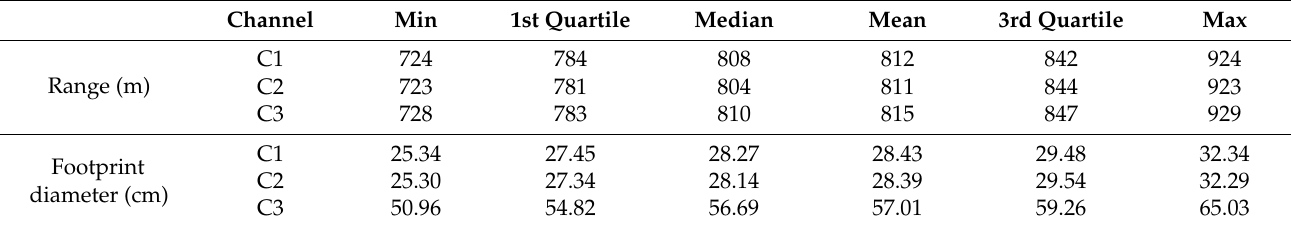
Table 1. Summary statistics of laser range and footprint